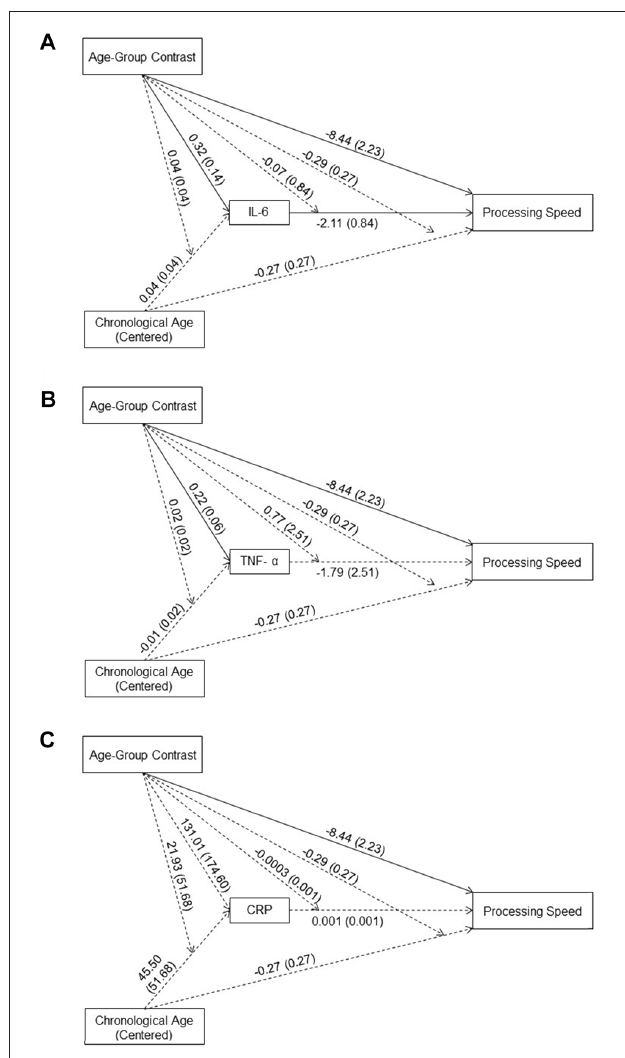
FIGURE 1 | Effects ( B ( SE )) of chronological age (centered), age-group contrast and interleukin 6 (IL-6) (A) , tumor necrosis factor alpha (TNF- α ) (B) , and C-reactive protein (CRP) (C) , and their interactions on processing speed. To improve readability, separate figures show the results from the three systemic inflammation biomarkers while all variables were considered in a single model. Solid lines indicate significance at p < 0.05. age group. Furthermore, TNF- α levels did not mediate the between-group age effect on processing speed (Effect = − 0.22, 95% CI = [ − 1.21, 0.31]) nor the within-group age effect in either the young (Effect = 0.06, 95% CI = [ − 0.16, 0.81]) or the older (Effect = − 0.01, 95% CI = [ − 0.14, 0.03])